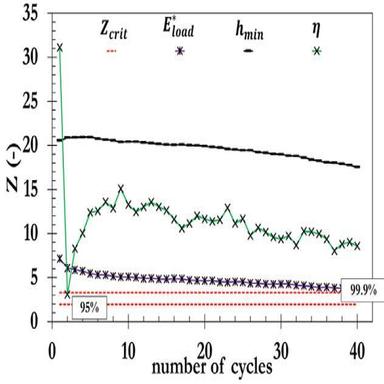
Evolution with cycles of the parameter Z calculated from composite core and composite surface of: instantaneous elastic modulus (\), residual depth (-) and energy ratio (×) and of Zcrit for an interval of confidence of 99.9% (upper red dashed line) and 95% (lower red dashed line).